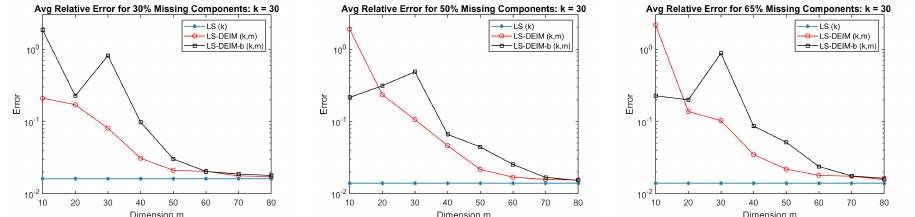
Figure 3. (Numerical Test 1) Average relative error of the reconstruction for 30%, 50%, and 65% missing components using the standard LS method and the accelerated LS with basis from rSVD, denoted by LS-DEIM for case (i) and LS-DEIM-b for case (ii) as described in Algorithm 4 for POD dimension k = 30 with DEIM dimension m = 10,20,30,40,50,60,70,80.